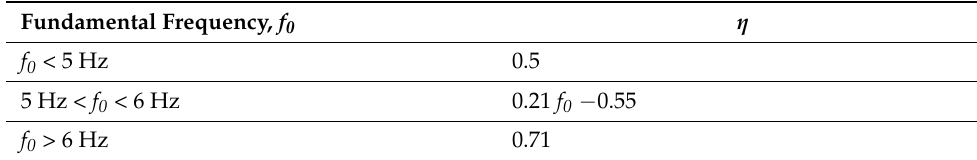
Table 6. Frequency factor η (SCI Design Guide).